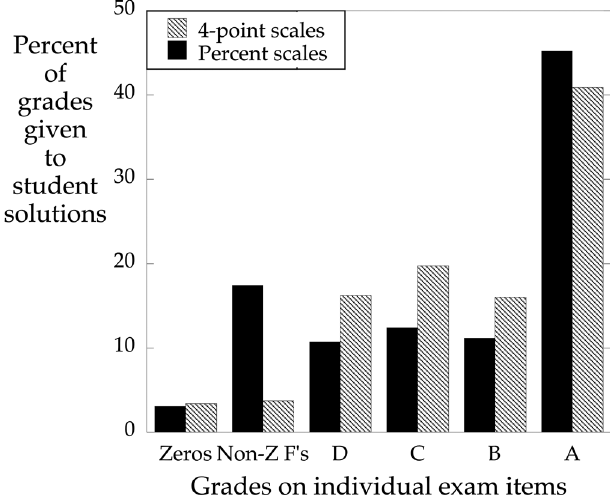
FIG. 4. Fractions of grades given to student answers on individual exam problems under each of the two grading regimes, 4-point scale and percent scale. The standard errors are quite small (range from (cid:2) 0 . 03% to (cid:2) 0 . 12% ) and so are not shown. Nevertheless, the choice of how to distribute the grades assigned at the boundaries does affect the totals. The largest effect is for nonzero F ’ s where percent scales have an extra weight (above 4-point grading) of between 13.3% (border grades counted in higher category) and 14.4% (border grades counted in lower